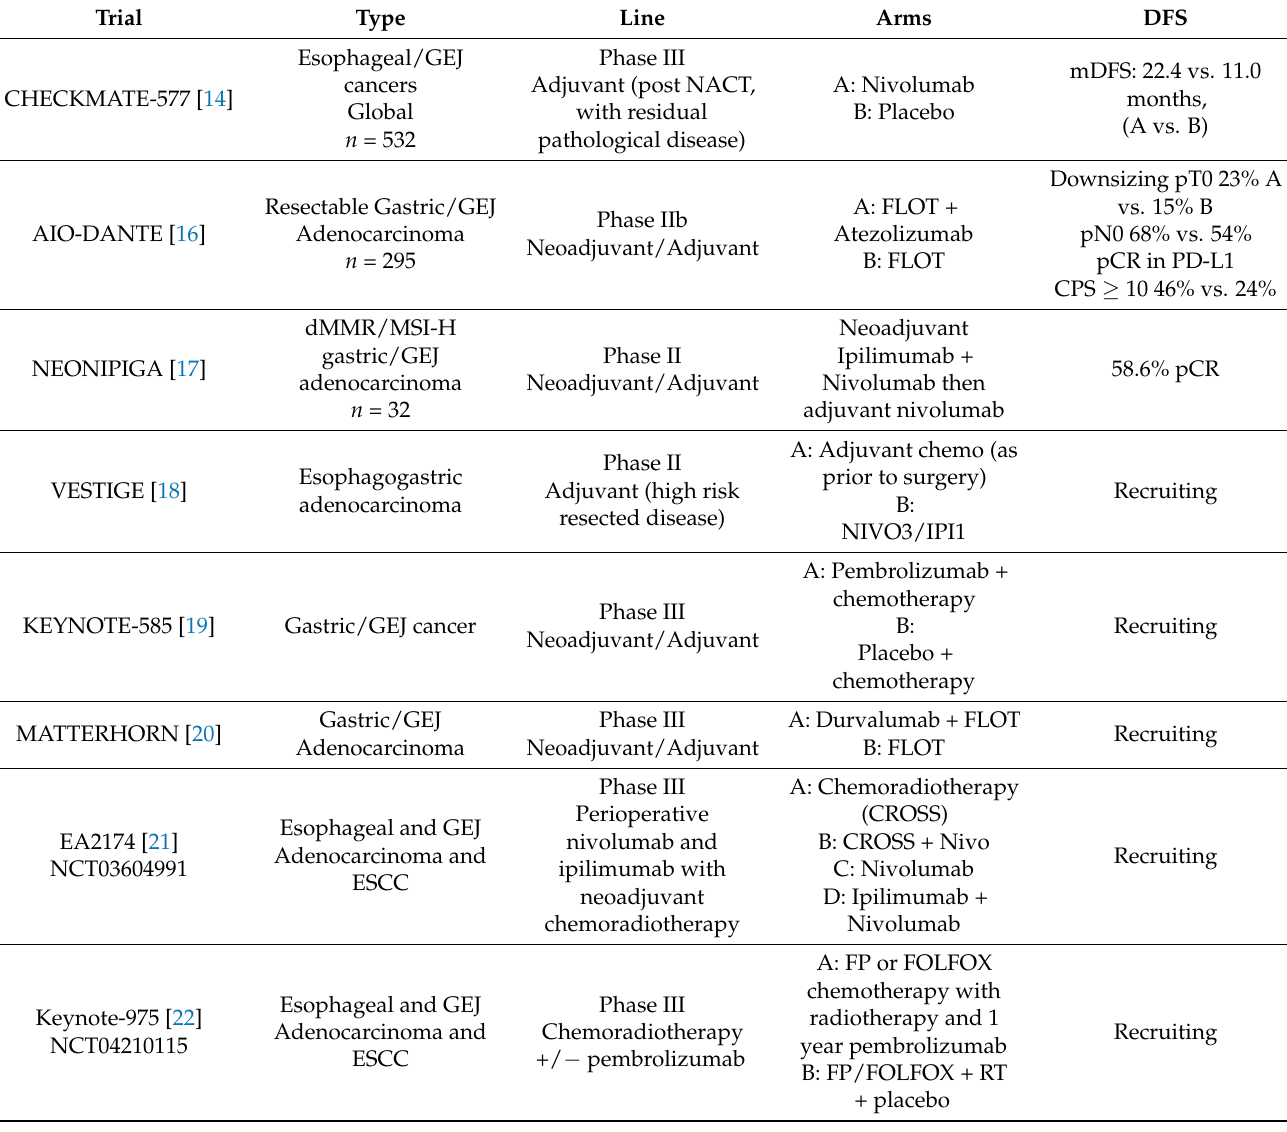
Table 1. Summary of relevant and awaited outcomes from immunotherapy trials in the locoregional esophagogastric